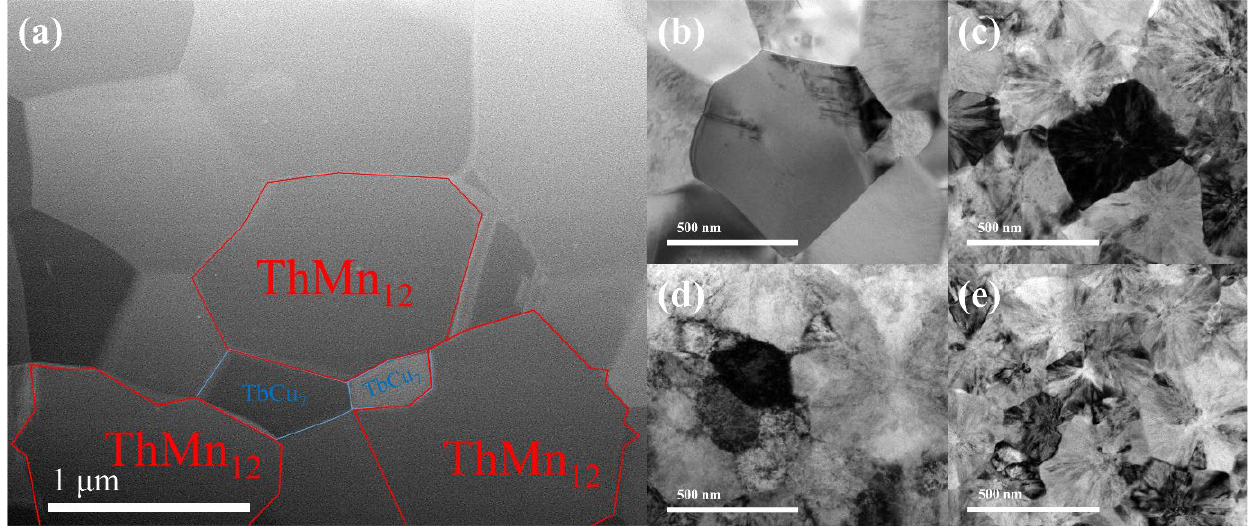
Figure 5. ( a ) HAADF image of the sample with the wheel speed of 6.5 m/s and HRTEM images of the Sm(Fe 0 . 8 Co 0 . 2 ) 10 Si 2 ribbons with the wheel speeds of ( b ) 6.5, ( c ) 13, ( d ) 26 m/s, and ( e ) 39 m/s.